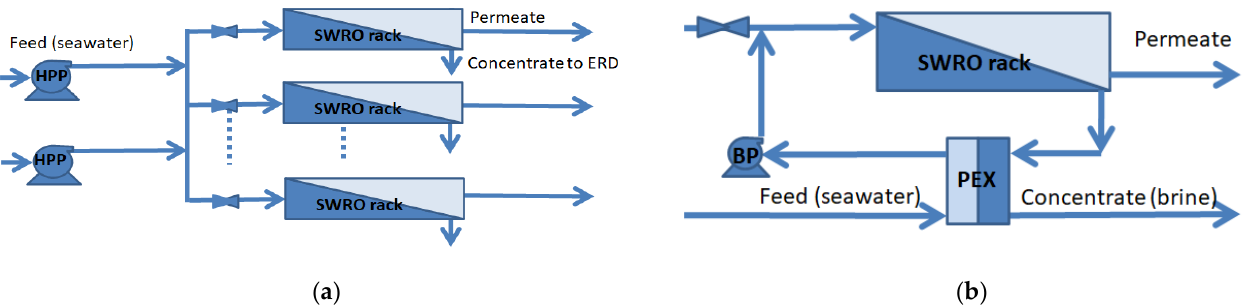
Figure 5. Innovative concept of gradual capacity SWRO rack consisting of the disconnection of specific pressure vessels to allow for adequate feed flow at operating pressure vessels.